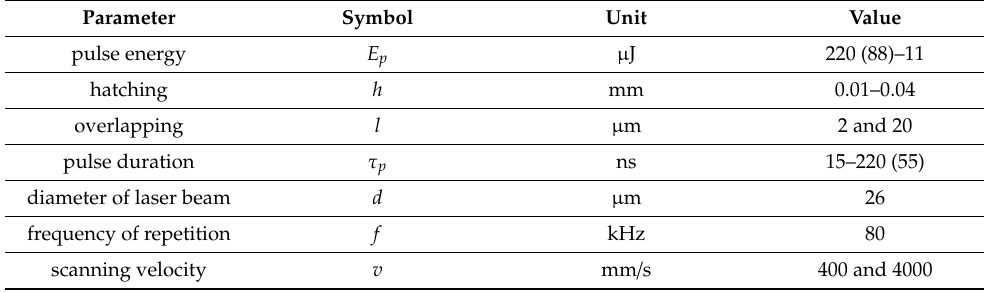
Table 1. Parameters of the fiber